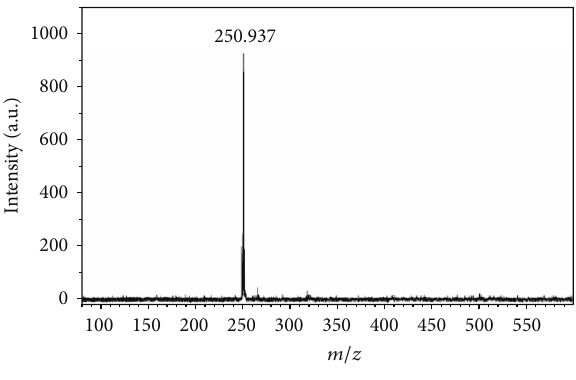
Figure 2: Mass spectrum of SBL.